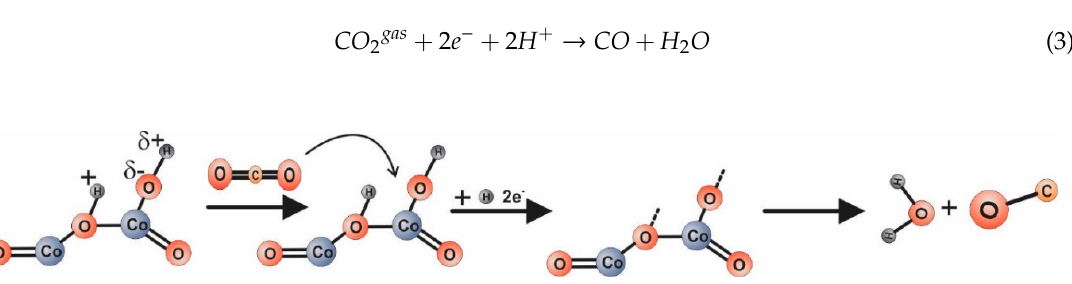
Figure 9. Possible conduction mechanism involved in CO 2 detection